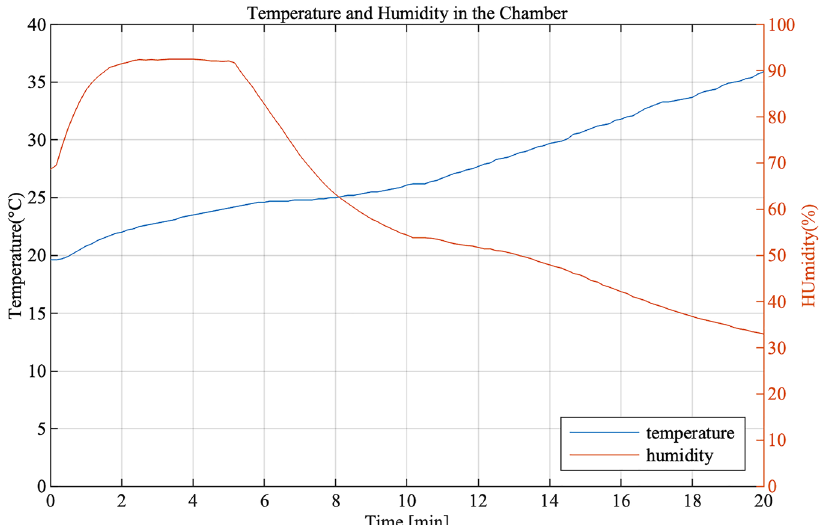
Figure 4. Temperature and humidity of one cycle treatment with DI water